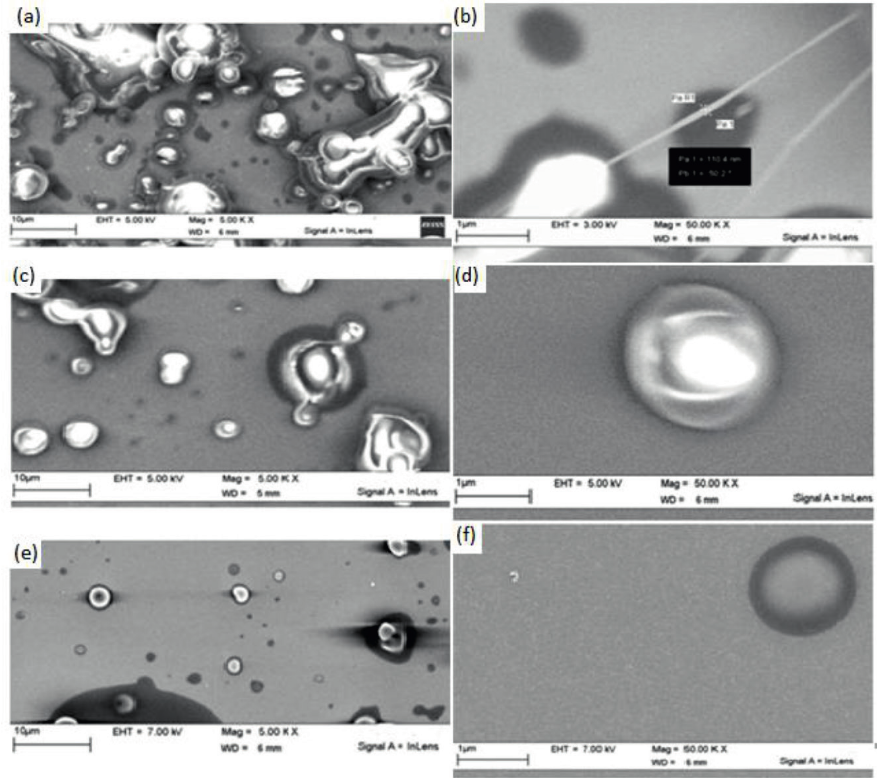
Fig. 4. SEM image of 15% PVP Nanofibers: a) Low Magnification, b) High Magnification, c) Low Magnification